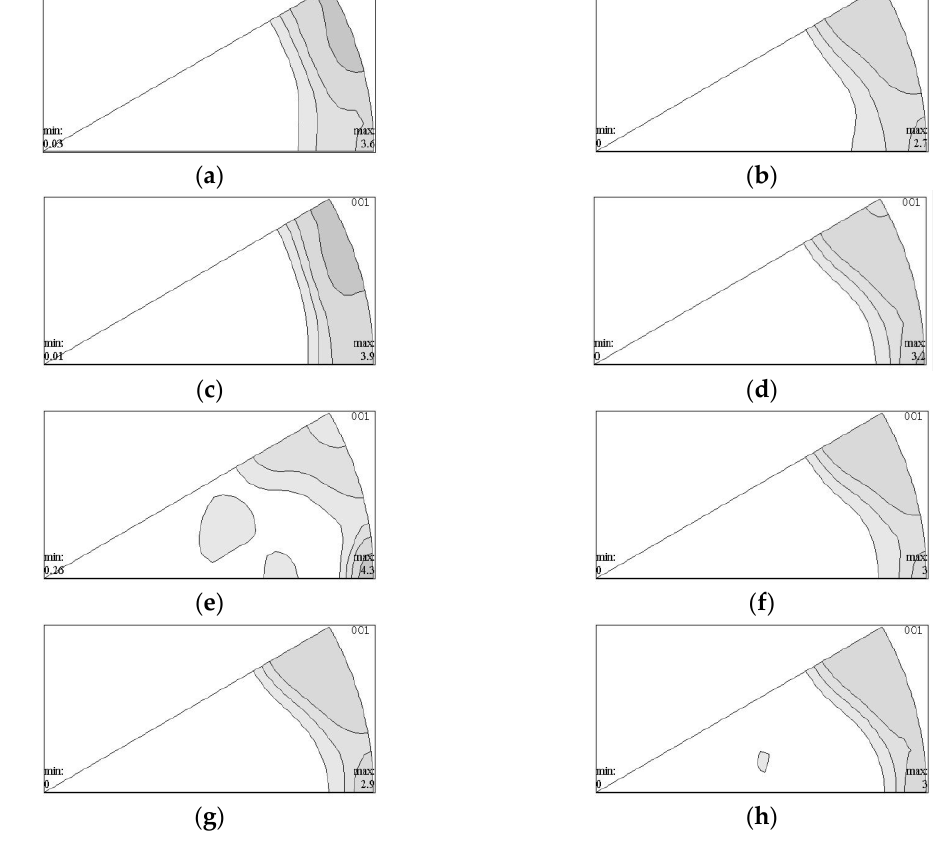
Figure 5. Inverse pole figures in extrusion direction from extruded round bars, left: <00 0̅ 1>, bottom right: <10 1 ̅ 0>, top right: <11 2 ̅ 0>: ( a ) Mg, ( b ) Mg + 0.75AlN, ( c ) Mg + 1.0AlN, ( d ) Mg + 1.5AlN, ( e ) ZW0303, ( f ) ZW0303 + 0.75AlN, ( g ) ZW0303 + 1.0AlN, ( h ) ZW0303 + 1.5AlN.